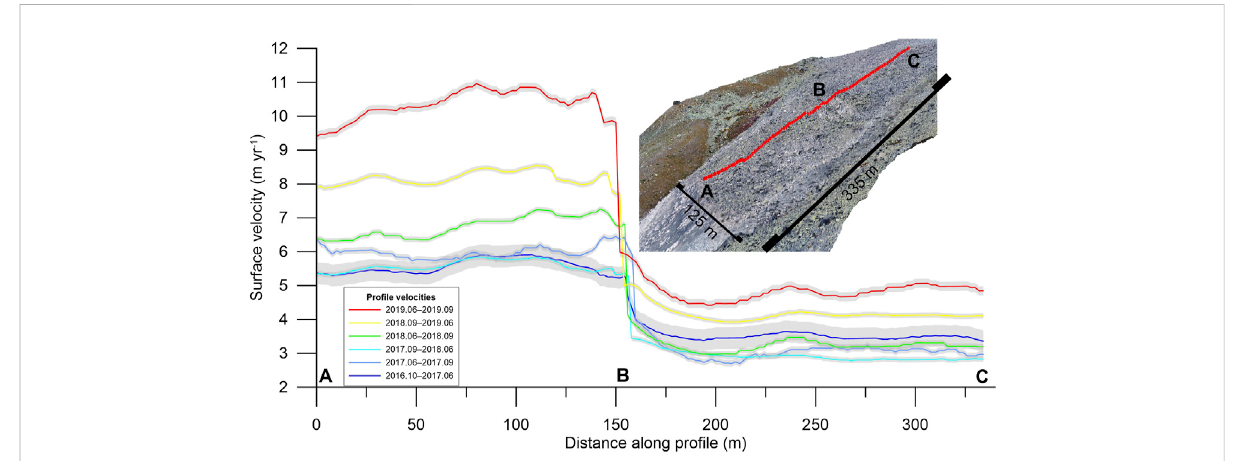
FIGURE 5 Longitudinal velocity pro fi les between 2016 and 2019 extracted from the red line shown on the inset (see Figure 1 for the plan view). The grey envelopes display the 90% con fi dence level (1.645× σ l ) on for each